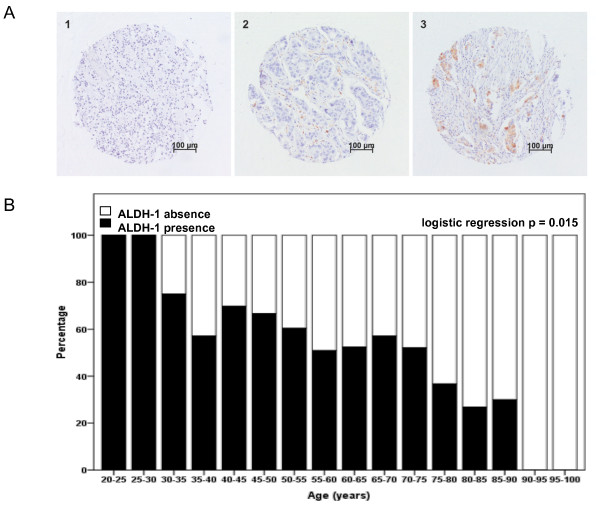
ALDH1 expression and distribution over age groups. A. Representative photographs of tissue microarray punches of human breast cancer specimens immunohistochemically stained for ALDH1 with representative examples of no staining (left panel), intermediate staining (middle panel) and strong staining (right panel). Bar represents 100 μm. B. ALDH1 status according to age (N = 496). Logistic regression P-value is shown.